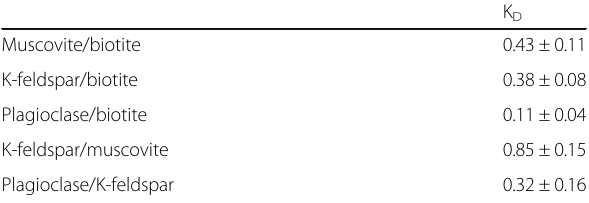
Table 2 Nitrogen partition coefficients